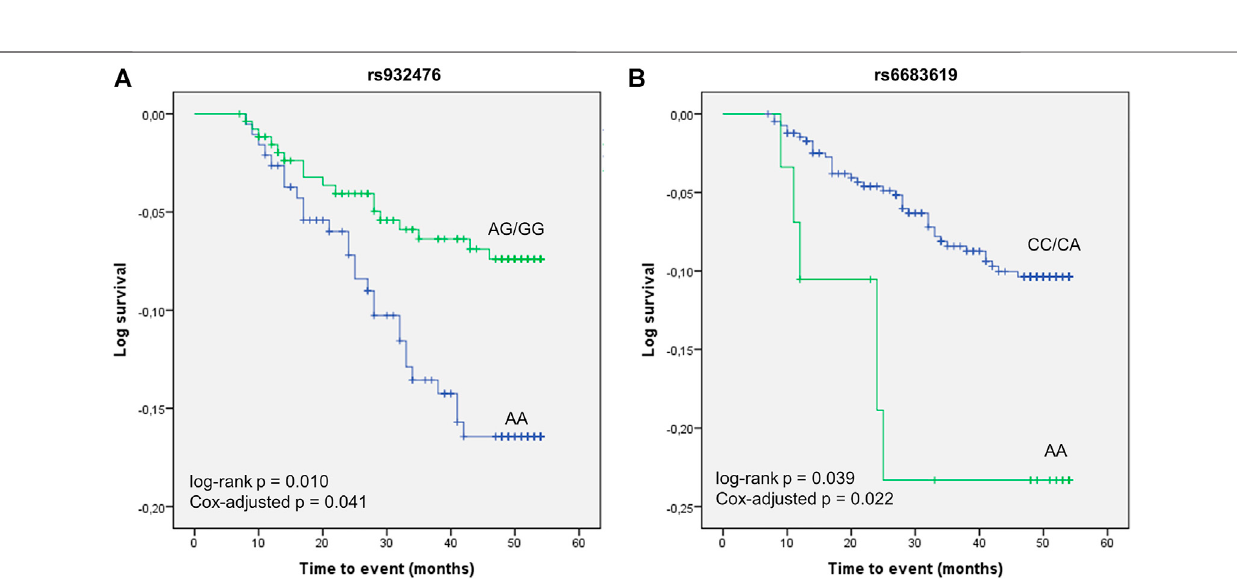
Frontiers in Pharmacology |